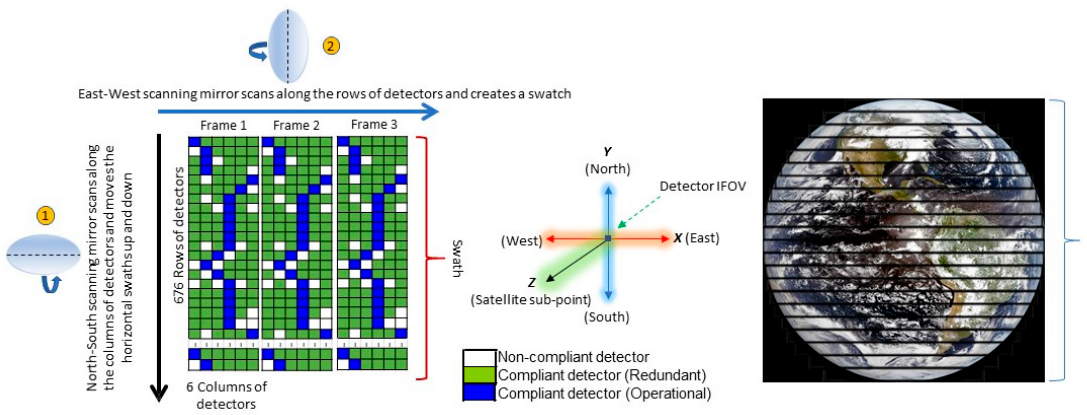
Figure 3. Graphic representation of mirrors and a detector array for the 1.61 µ m spectral band (6 columns and 676 rows). Within each focal plane array, there are multiple detector elements in each row, the best of which is selected for output on a row-by-row basis. Each “Frame” is the output of one integration time. Operating the scan mirror 1 (North–South) and scan mirror 2 (East–West) together results in 22 swaths that cover the entire observable hemisphere.